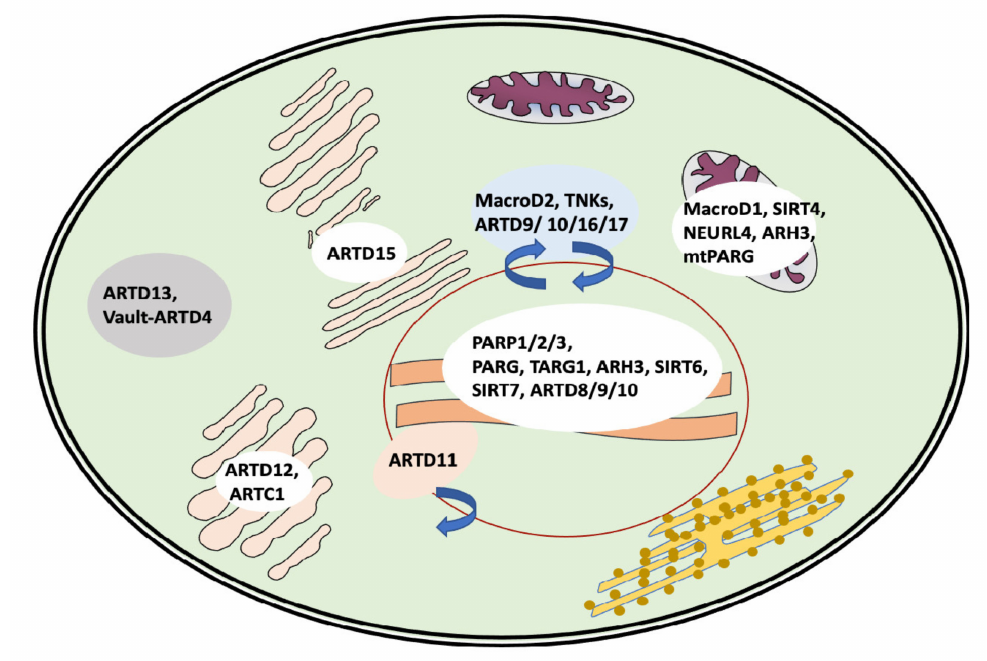
Figure 3. Intracellular localization and shuttling of the major players of the MARylation/PARylation